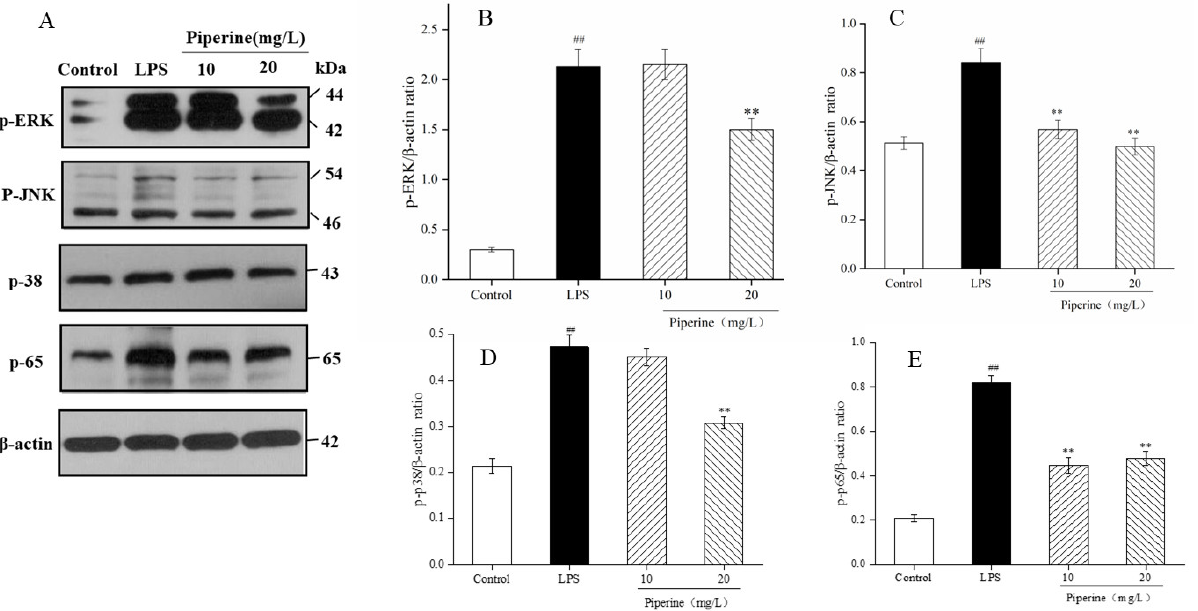
Figure 6. Piperine suppressed LPS-induced inflammatory activity via MAPK and NF-κB pathways. ( A ) SDS-PAGE electrophoretogram of p-ERK, p-JNK, p-p38 and p-p65. ( B ) p-ERK/ACTIN ration. ( C ) p-JNK/ACTIN ration. ( D ) p-p38/ACTIN ration. ( E ) p-p65/ACTIN ration. Ave ± SD, ## p < 0.01 vs. control group; ** p < 0.01 vs. LPS group.